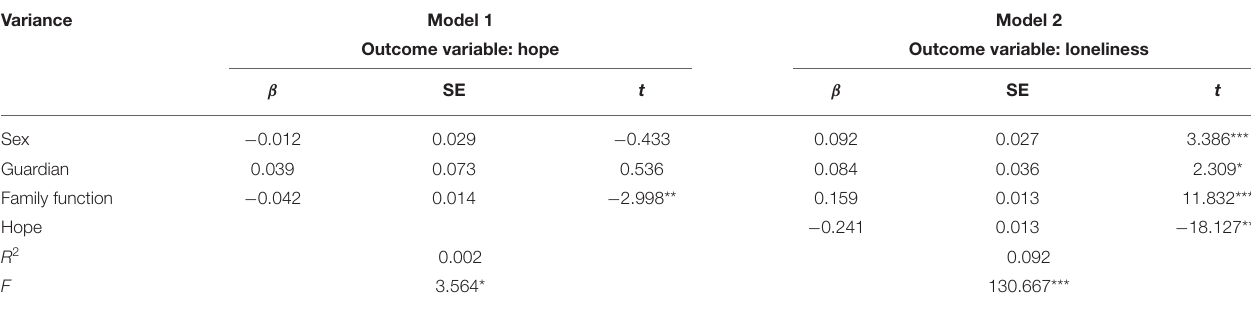
TABLE 3 | Results of the mediation model. Variance Model 1 Model